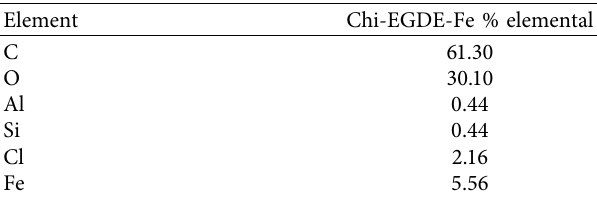
Table 1: Elemental analysis of Chi-EGDE-Fe beads. Element